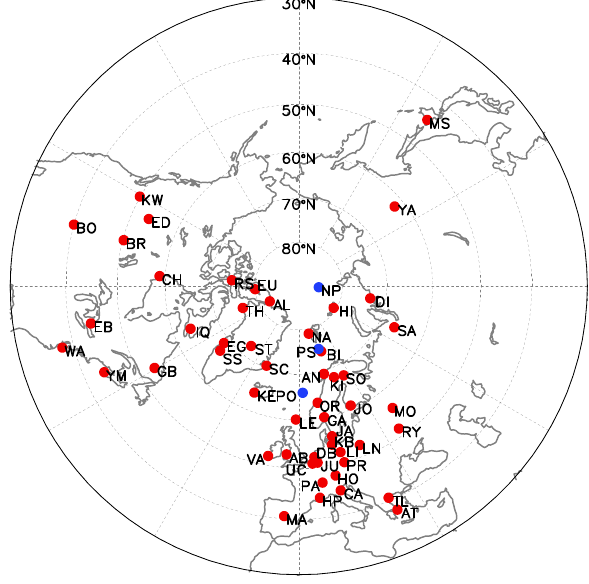
Fig. 3. Ozone sonde stations used in the ozone data set. Ships and the ice drifting station NP-35 are shown in